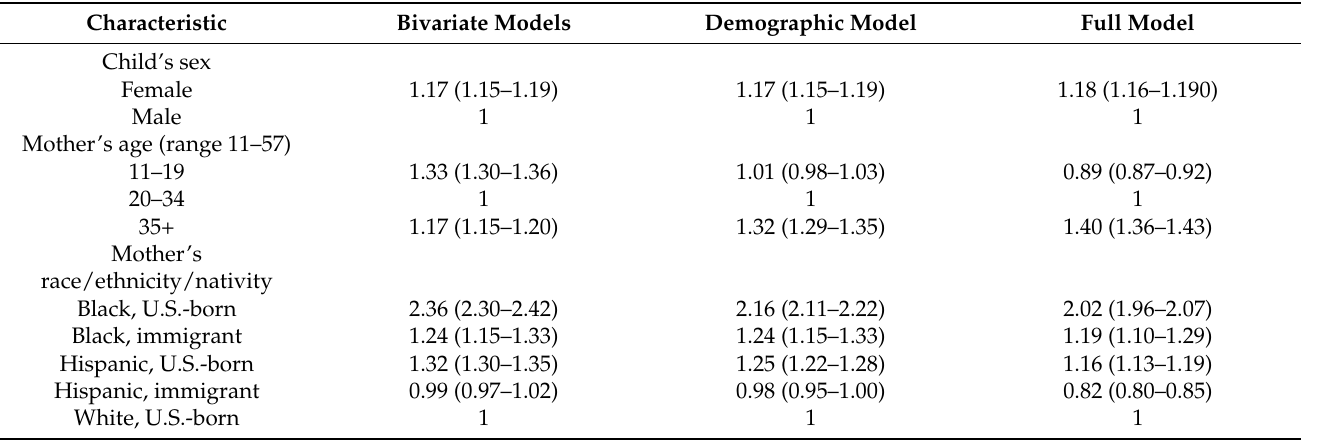
Table A1. Odds and 95% confidence intervals of low birth weight, 2009–2011 Texas natality files, n =